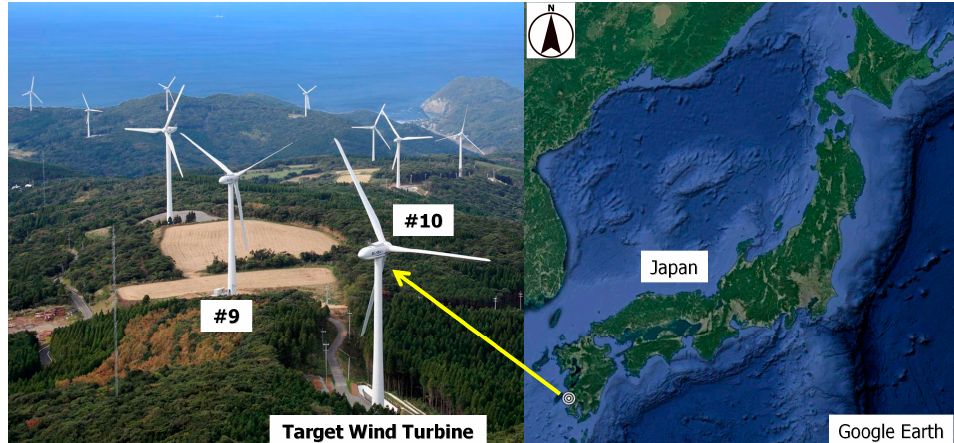
Figure 1. Map of the Kushikino Reimei Wind Farm and the surrounding area.